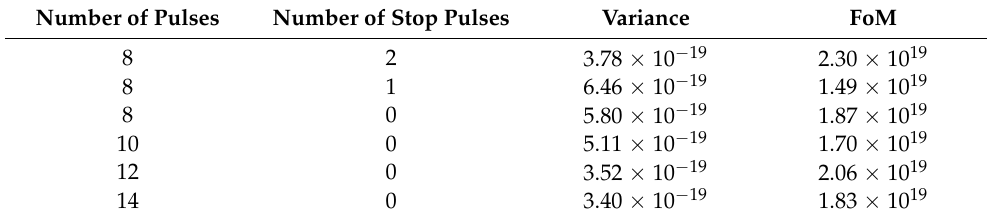
Table 4. Comparison of pattern options for a flow rate of 40 L/h.